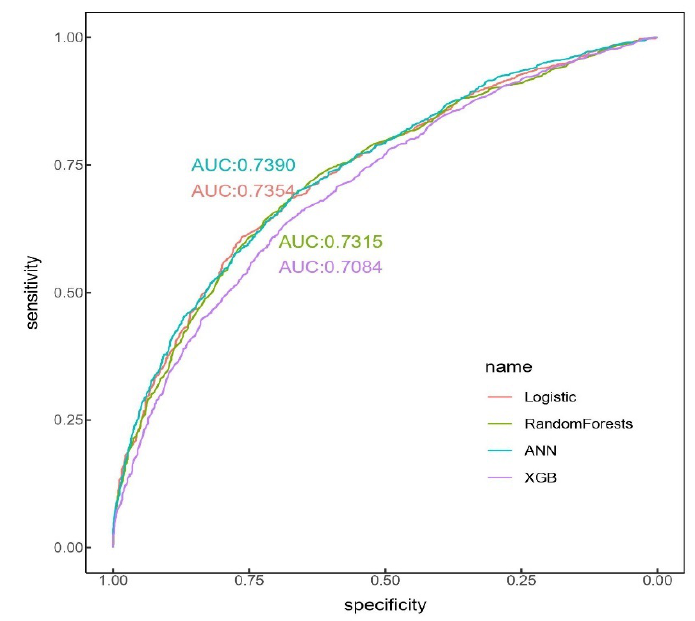
Figure 1. ROC curve of four machine learning methods.